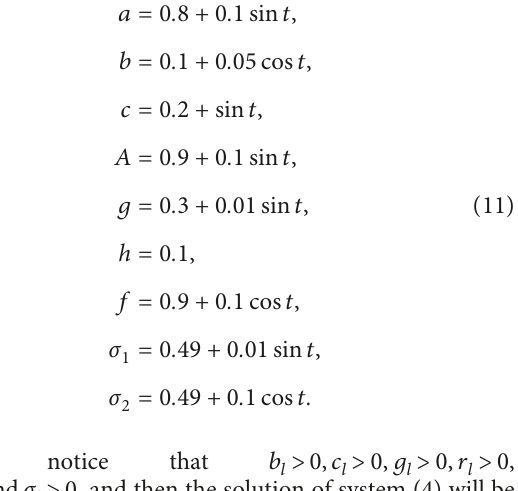
, c , g , and r l > 0 l > 0 l > 0 l > 0, but ρ l < 0and σ l <